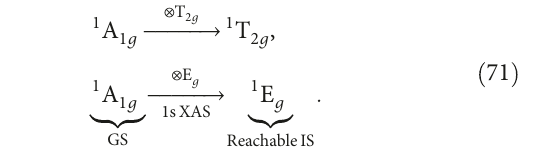
Figure 44: 2p XES projections for Fe 3+ ( 3d 5 ) for 10D q = 0 1 eV to 4 2eV . The high spin to low spin transition between 10D q ≈ 3 0 e V and 3.3eV also induces visible changes in the 2p XES. The most notable is the appearance of the two peaks related to the fi rst 2 A intermediate state symmetry around E